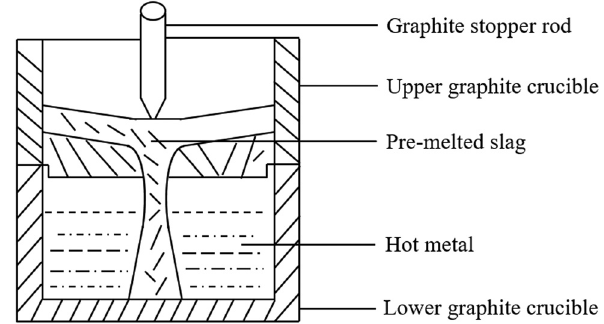
Table 1: Chemical composition of designed slags ( wt% )